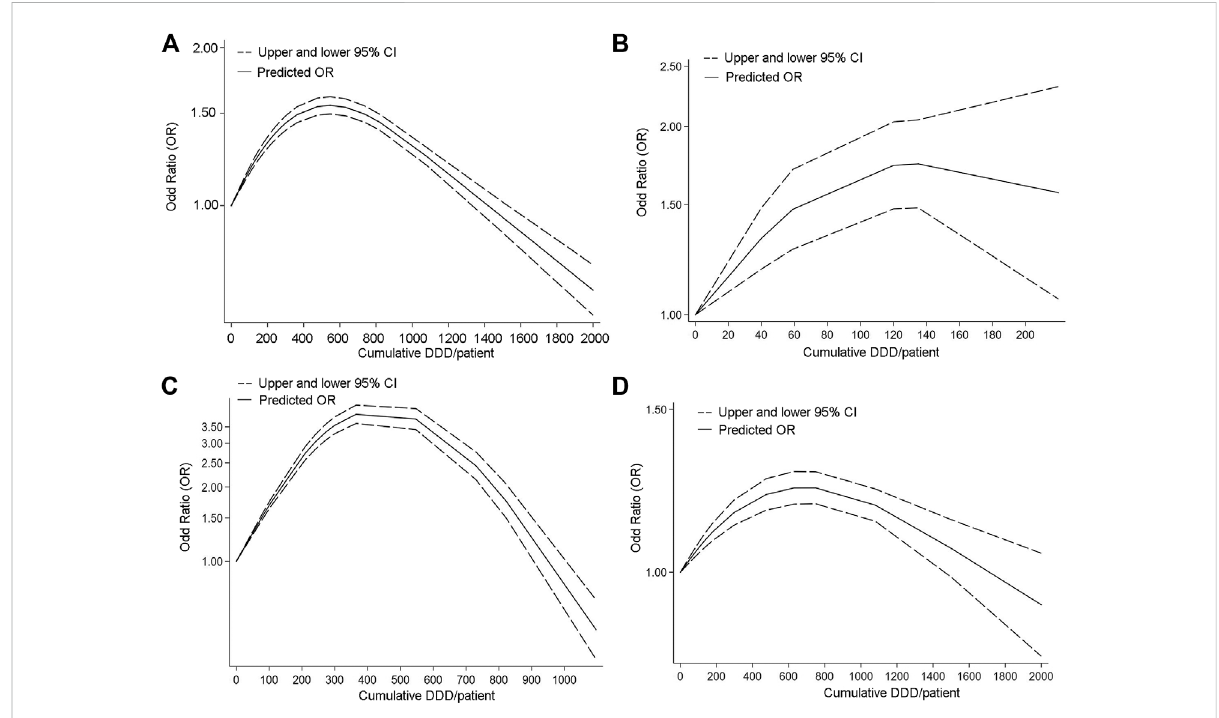
FIGURE 3 Dose response curve of Studies analyzing relationship between long-term PPI use and Hepato-Biliary-Pancreatic cancer. [ (A) Hepato-Biliary- Pancreatic cancer. (B) biliary tract cancer. (C) hepatocellular carcinoma. (D) pancreatic